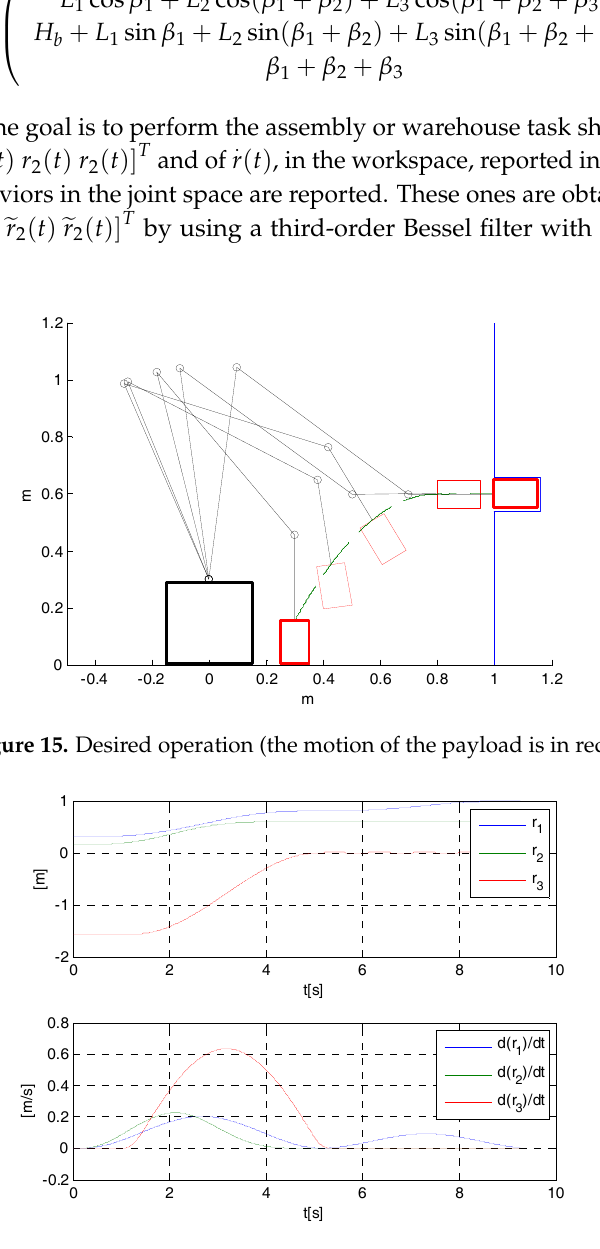
Figure 16. Time histories of r ( t ) and . r ( t ) in the workspace.